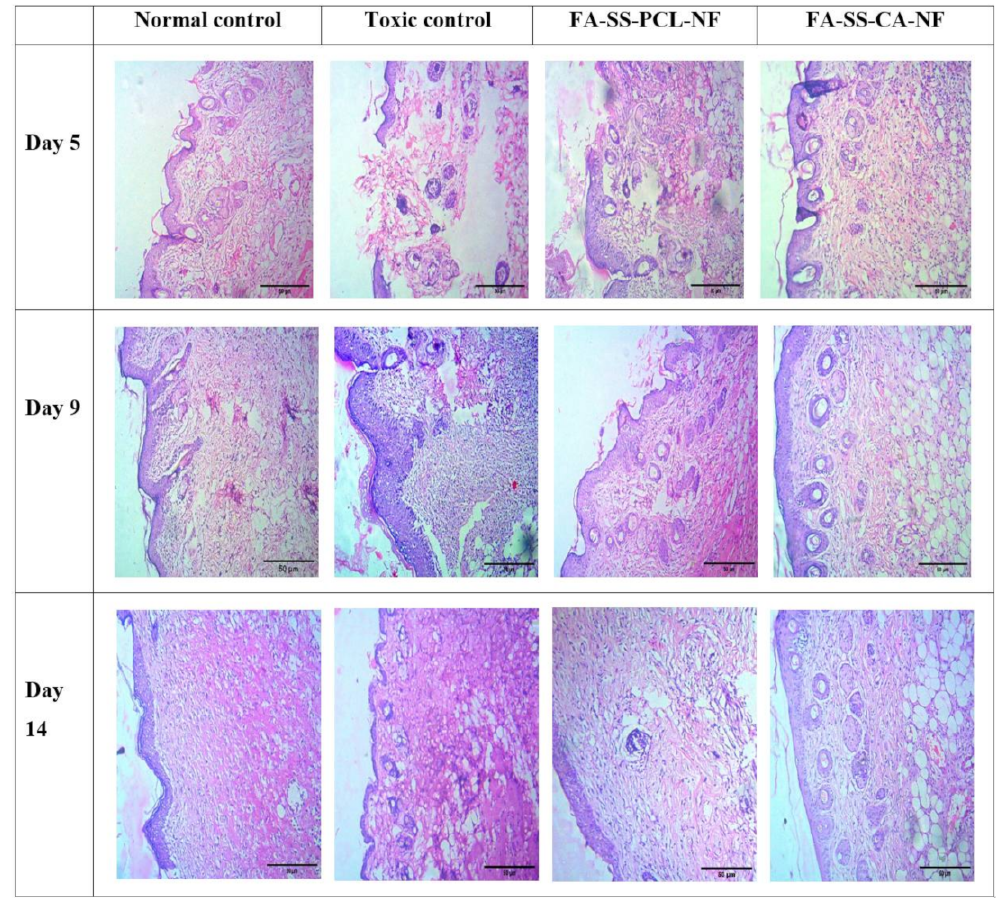
Figure 16. Histopathological images of normal control, toxic control, FA-SS-PCL-NF, and FA-SS-CA- NF (scale bar = 50 µ